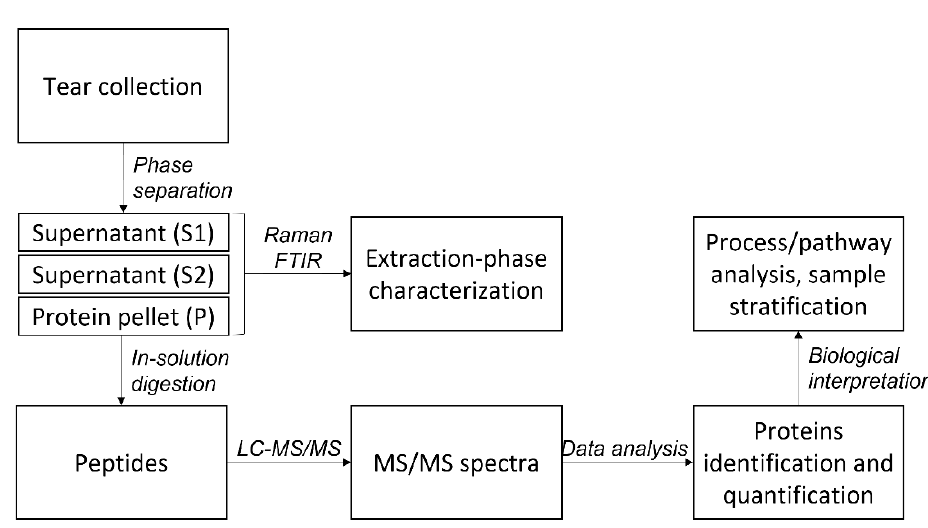
Figure 11. Flowchart illustrating the main steps of the analytical